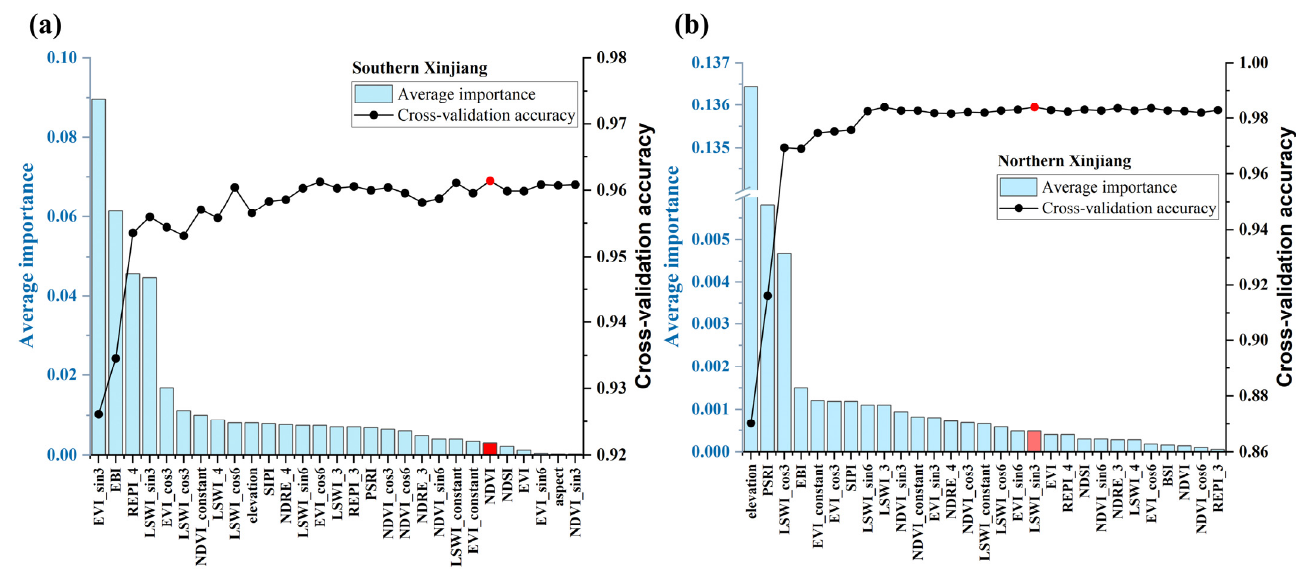
Figure 6. The variable permutation importance measures in descending order and the average cross- validation accuracy of different feature combinations. ( a ) represents southern Xinjiang. ( b ) represents northern Xinjiang. The cross-validation accuracy peaks at the features with red color.